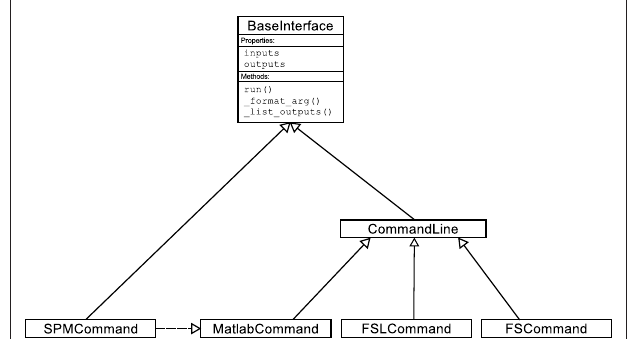
FiGure 2 | Simplified hierarchy of interface classes. An object-oriented design is used to reduce code redundancy by defining common functionality in base classes, and makes adding new interfaces easier and quicker. MatlabCommand, FSLCommand, and FSCommand extend the CommandLine class to provide functionality specific to executing MATLAB, FSL, and FreeSurfer programs. The SPMCommand class defines functions that simplify wrapping SPM functionality. The dashed line indicates that the SPMCommand class uses the MatlabCommand class to execute the SPM matlab scripts generated by the SPM